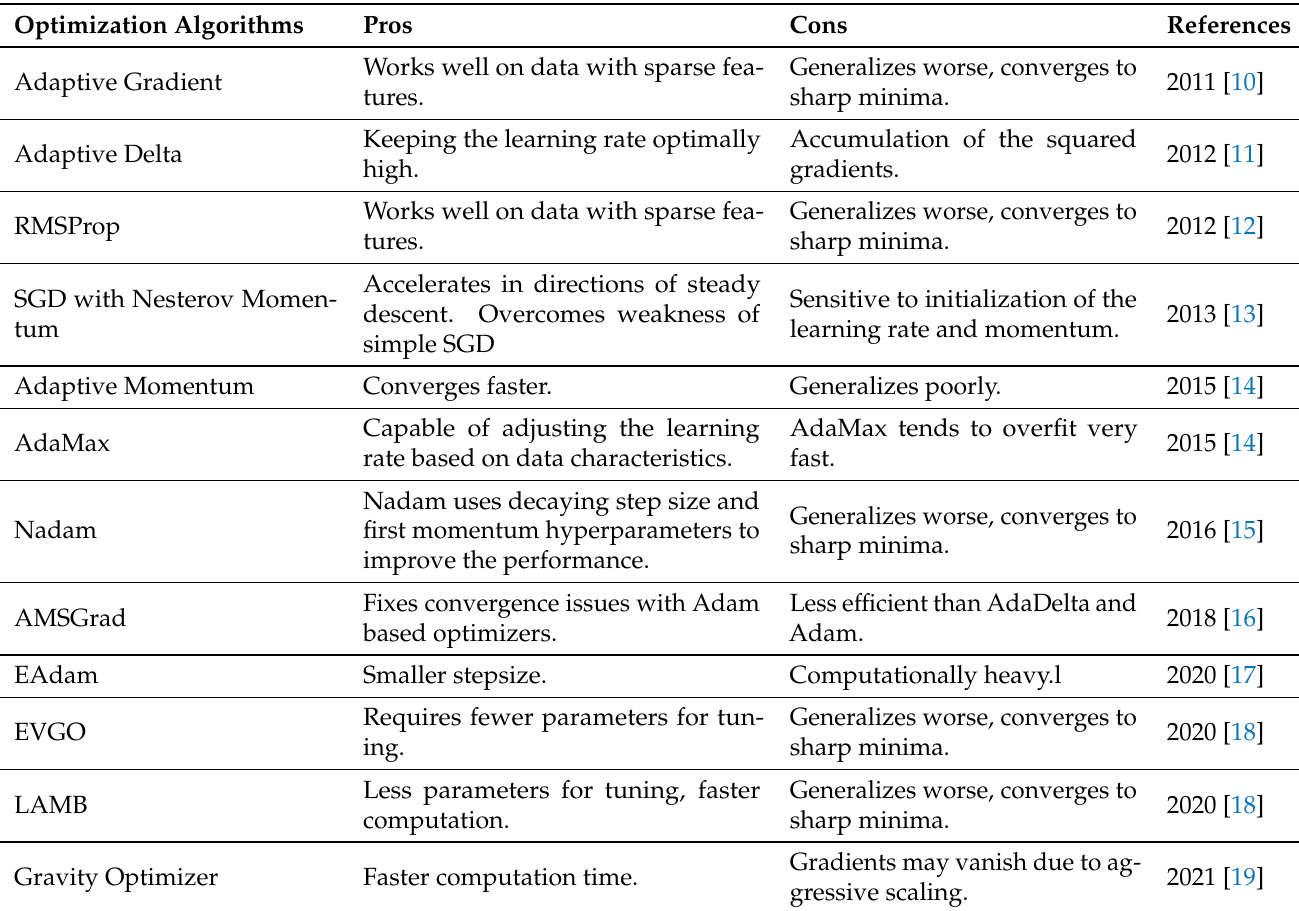
Table 1. History of